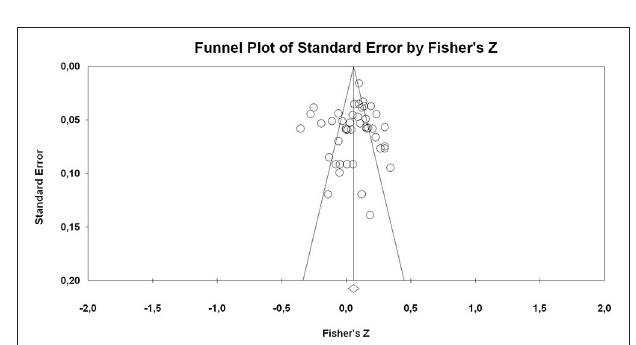
FIGURE 2 | Funnel plots of effect sizes of the correlation between ITI and student’s verbal domain achievement.